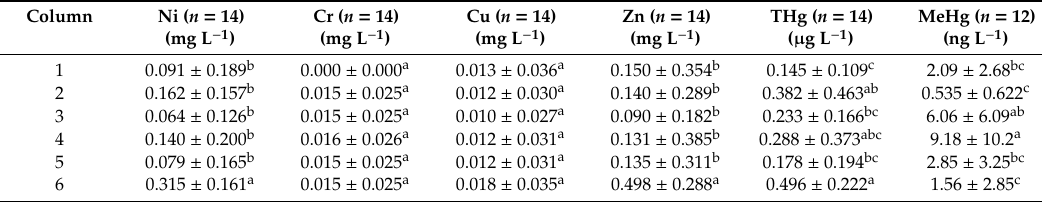
Figure 5. The remaining proportion (%) of ( a ) Ni, ( b ) Cr, ( c ) Cu, ( d ) Zn, ( e ) Hg, and ( f ) the concentration of MeHg in six columns. The remaining proportion in aqueous phase was calculated through dividing the concentration of each contaminant by the concentration on the first day. Table 6. Metal concentrations in six columns before adding acid (day